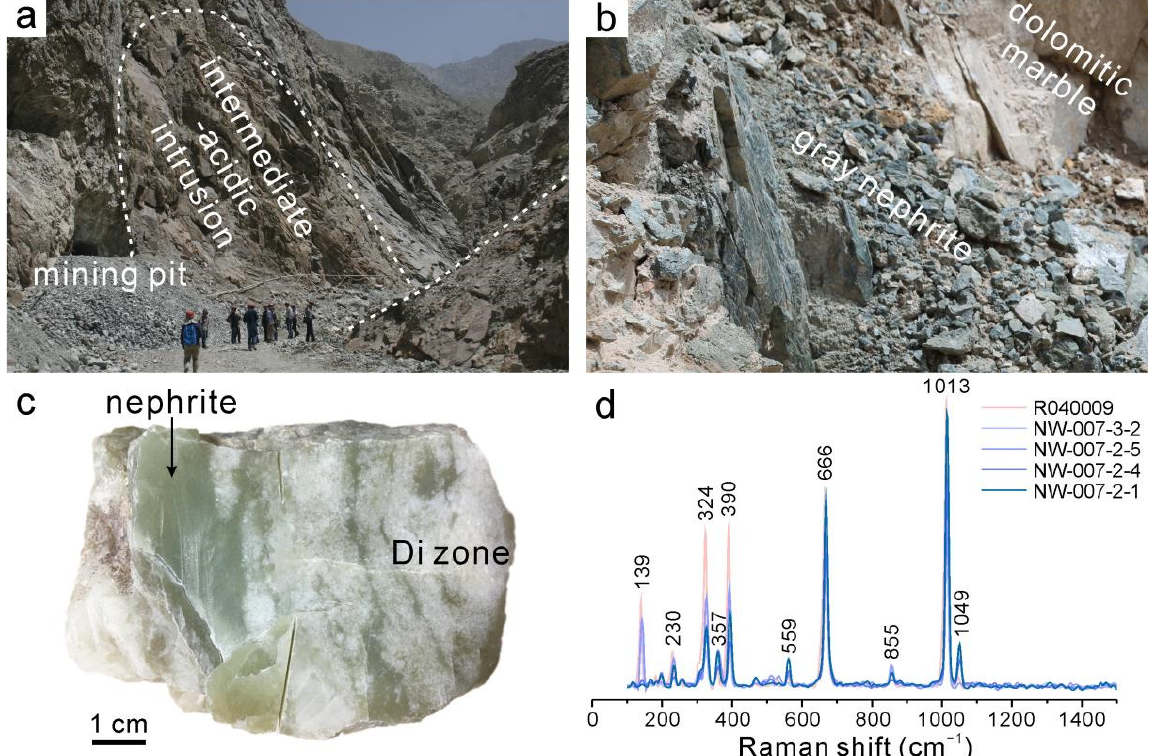
(Figure 2a). Their shapes—which were restricted by the outline of dolomite marbles—are irregular massive, veined, lentoid and layered.